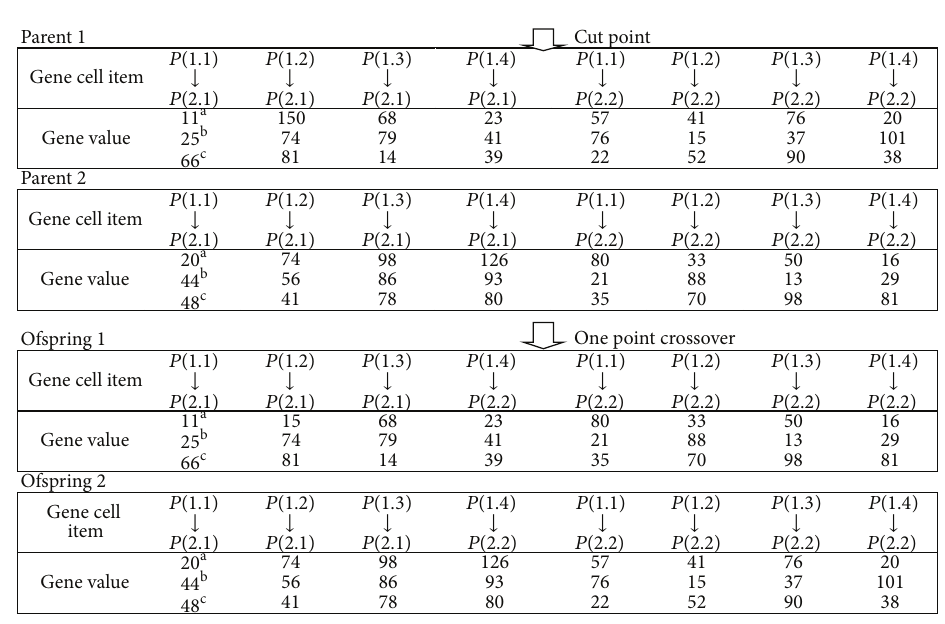
Figure 2: Structure of chromosome.